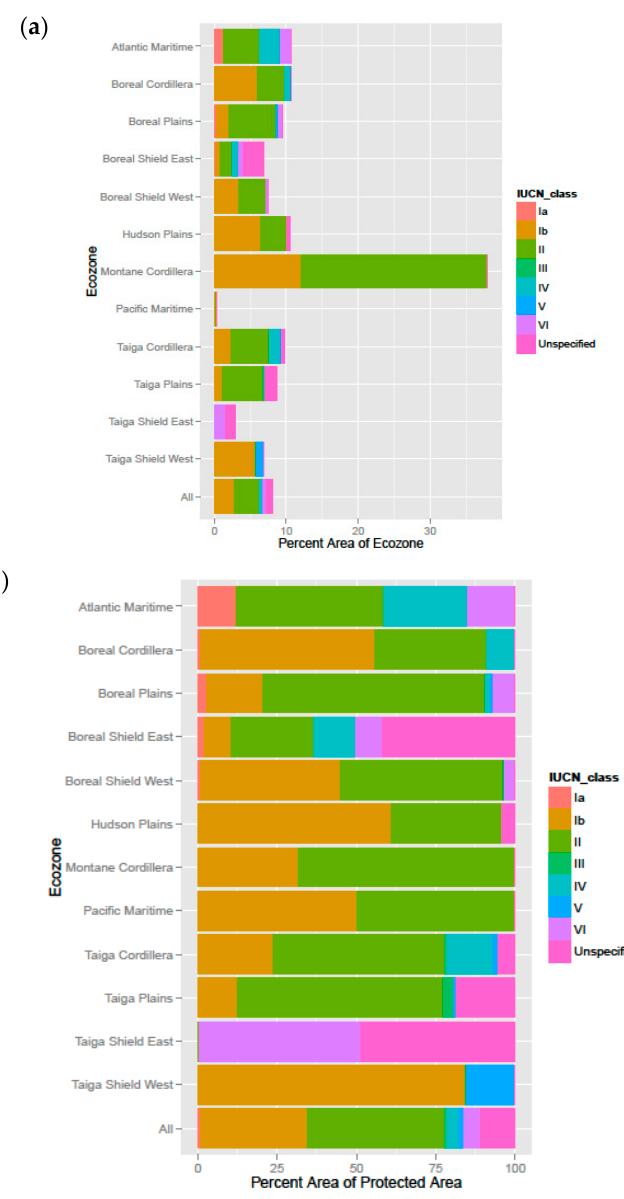
Figure 3. IUCN management categories for PAs in boreal ecozones, aiming to show balance among IUCN types. The stacked bar for each ecozone shows ( a ) the proportion by total amount of protected area found in each boreal ecozone ([9] and ( b ) the proportion by amount of protected area in each ecozone.